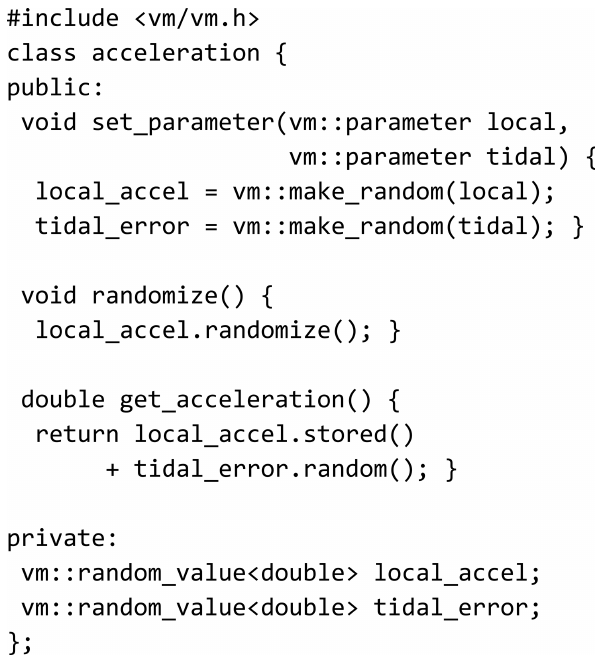
Figure 2. Implementation of VPB’s acceleration module.